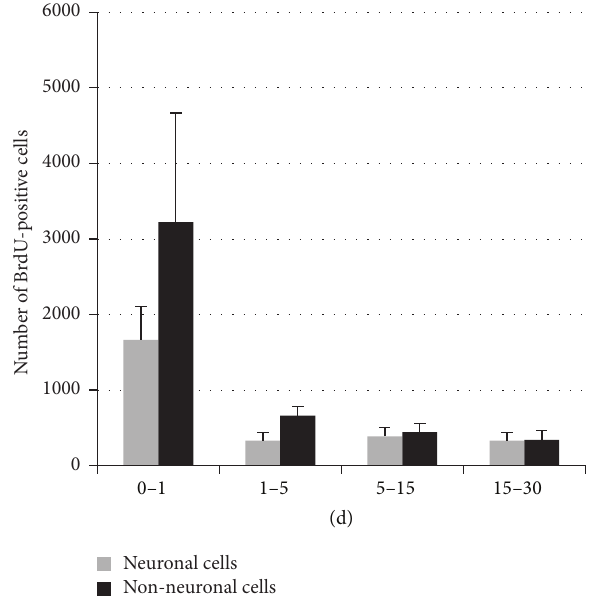
Figure 9: Histograms showing stereological analysis of BrdU- positive cells. The number of neuronal and nonneuronal BrdU- positive cells measured in each time window was divided by the days of BrdU treatment in order to predict the daily rate of cells whichincorporateBrdUinthedifferenttimewindows.(SeeFigure 2 for experimental design of BrdU injection.) All data are expressed as average ± standard error. The data were analyzed using both ANOVA and 𝑡 -test analyses. ∗∗ 𝑃 ≤ 0.01 ; ∗∗∗ 𝑃 ≤ 0.001 versus 0-1d